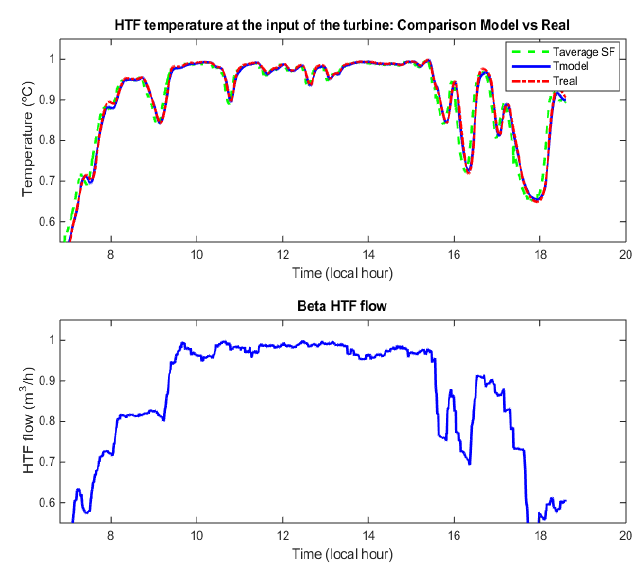
Figure 10. Mojave Beta, HTF temperature at the input of the Steam generator: ( top ) model (solid blue) and real (red dash-dotted); and ( bottom ) HTF flow.